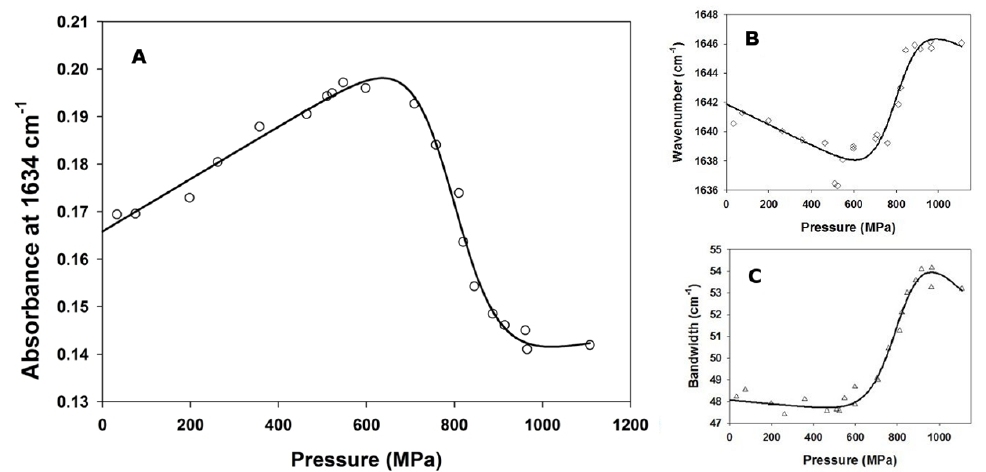
Figure 4. Pressure-induced unfolding curves of PemA followed by FTIR spectroscopy at 25 °C, through monitoring ( A ) the absorbance at 1634 cm − 1 , ( B ) the wavenumber corresponding to the band maximum and ( C ) the amide I’ bandwidth. The solid lines represent the best fits of equation (3) in [88] to the data, yielding the following average apparent values for the parameters: ∆ G °(H 2 O) NU = 33 ± 4 kJ·mol − 1 , Δ V = − 41 ± 5 mL·mol − 1 and P m = 800 ± 7 MPa.